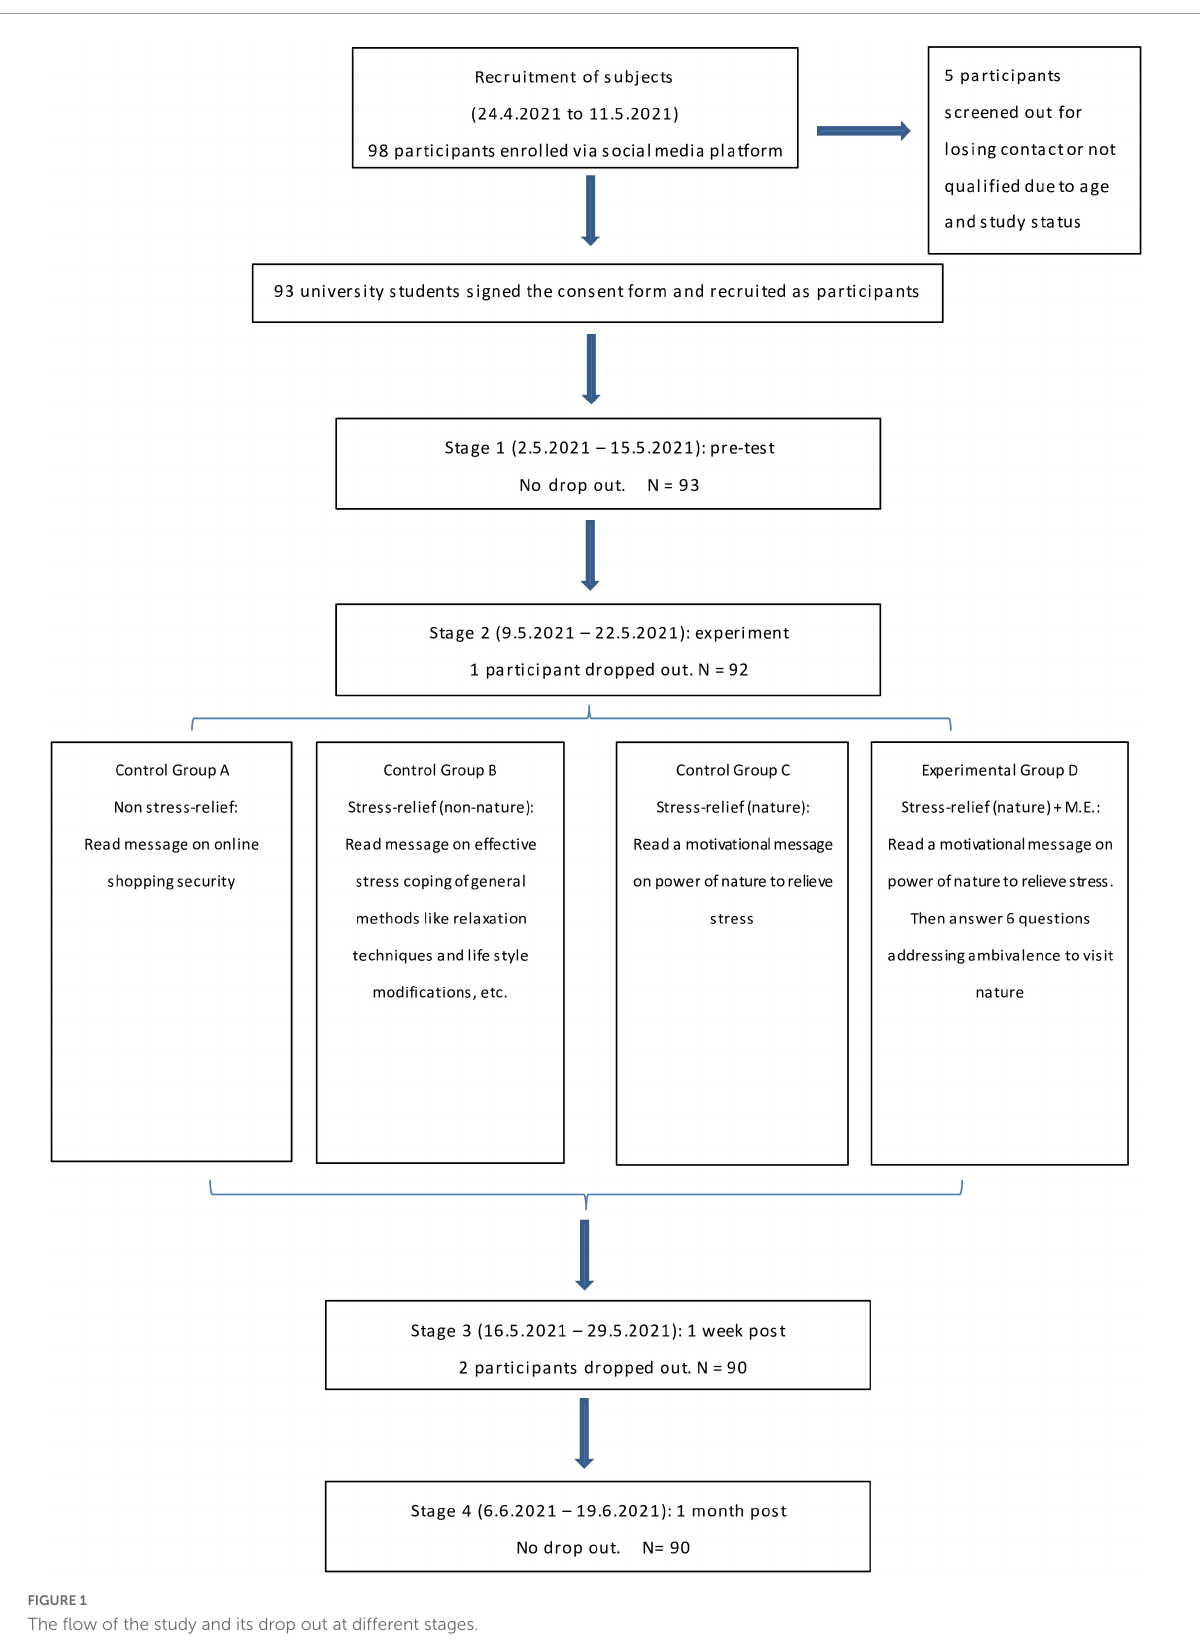
FIGURE1 The flow of the study and its drop out at different